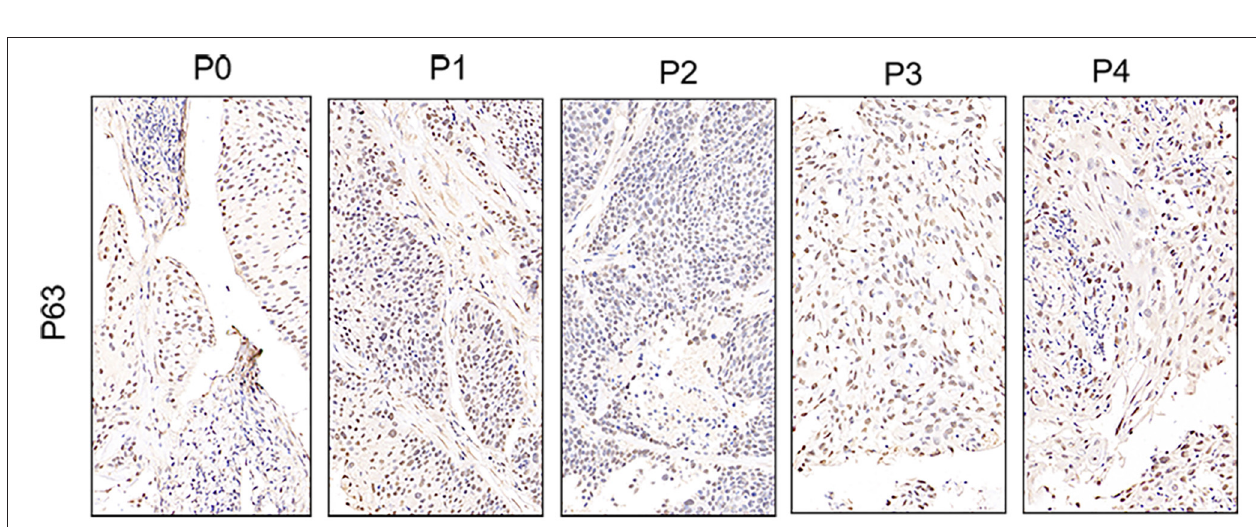
FIGURE 2 | Immunohistochemistry presented that P63 was expressed in the esophageal patient tissue (P0) and all the series passages (P1, P2, P3, and P4). The figure provided is a representative image, and other images are provided in the Supplementary Files; ×